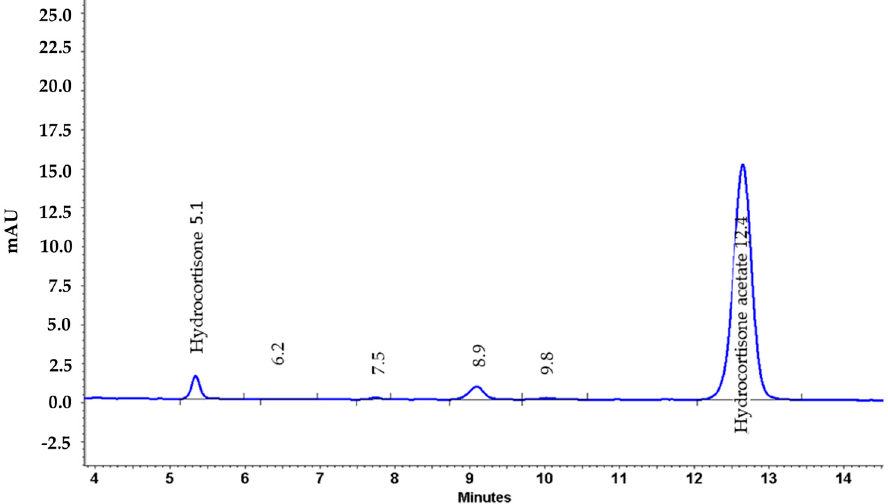
Figure 9. HPLC fingerprint of HCA from the acceptor medium.